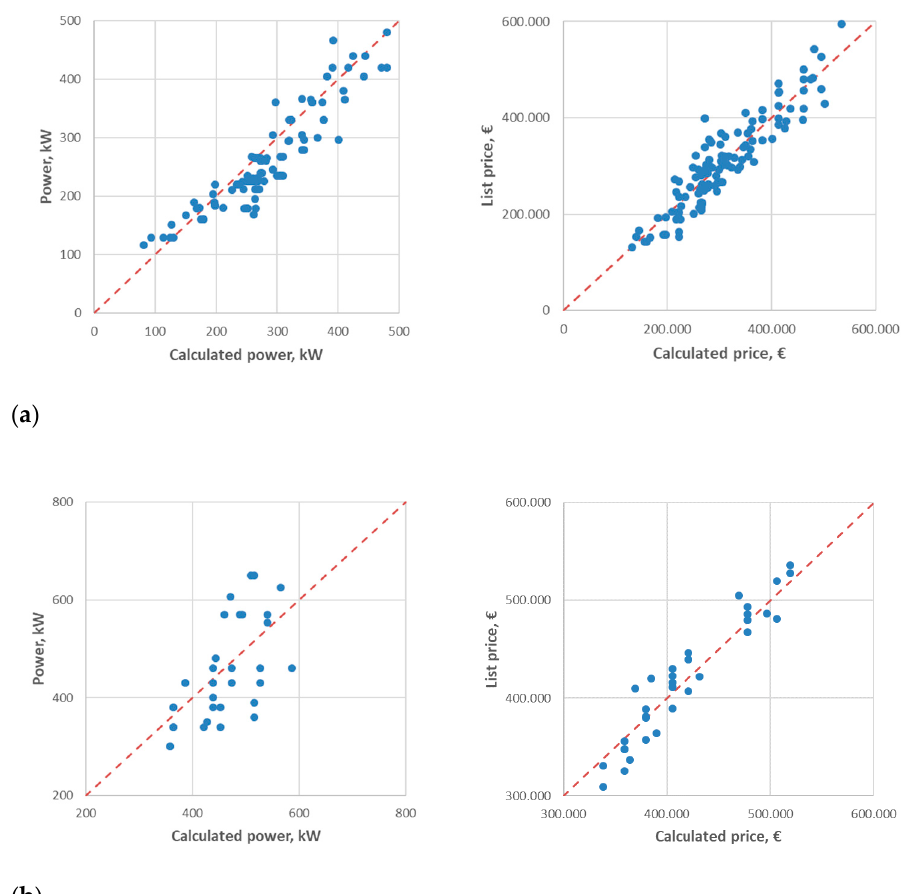
Figure 2. Qualitative evaluation of the multilinear models for combine ( a ) and forage ( b ) harvesting machines.